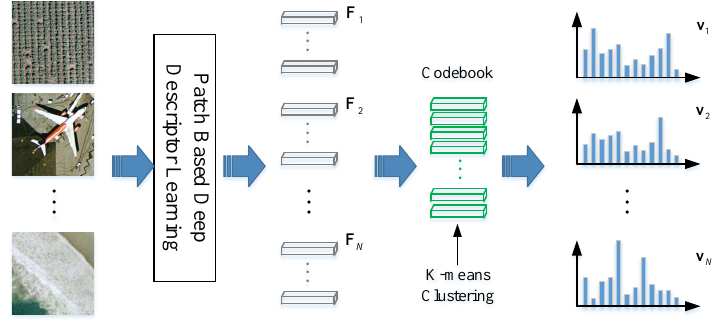
Figure 8. Pipeline of deep bag-of-words